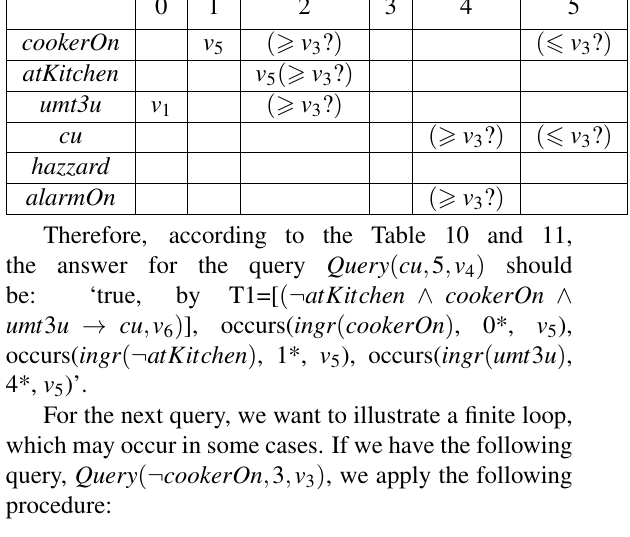
Table 11. The Searching Process of Query ( ¬ cu , 5 , v 3 )